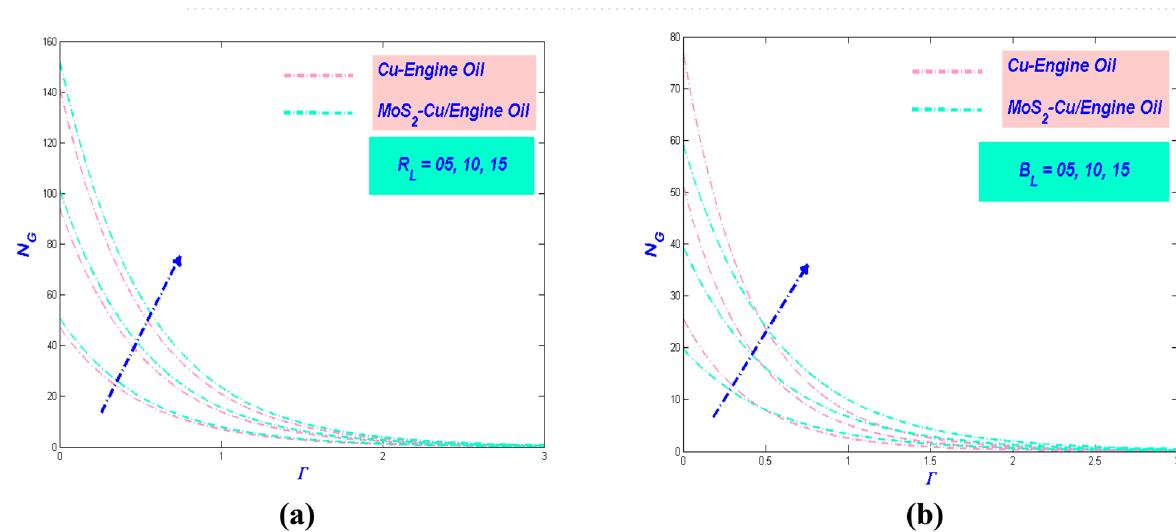
Figure 11. ( a ) Temperature and ( b ) entropy variations with E L .